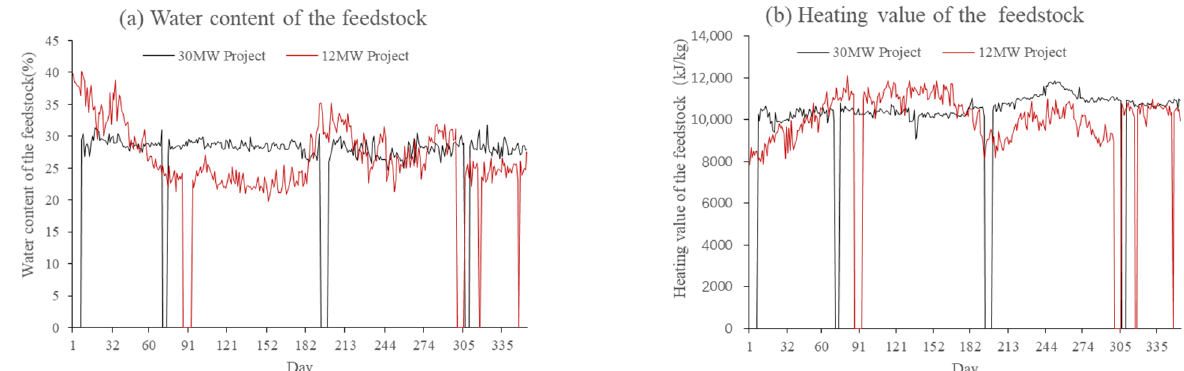
Figure 2. Water content ( a ) and heating value ( b ) of the feedstock.